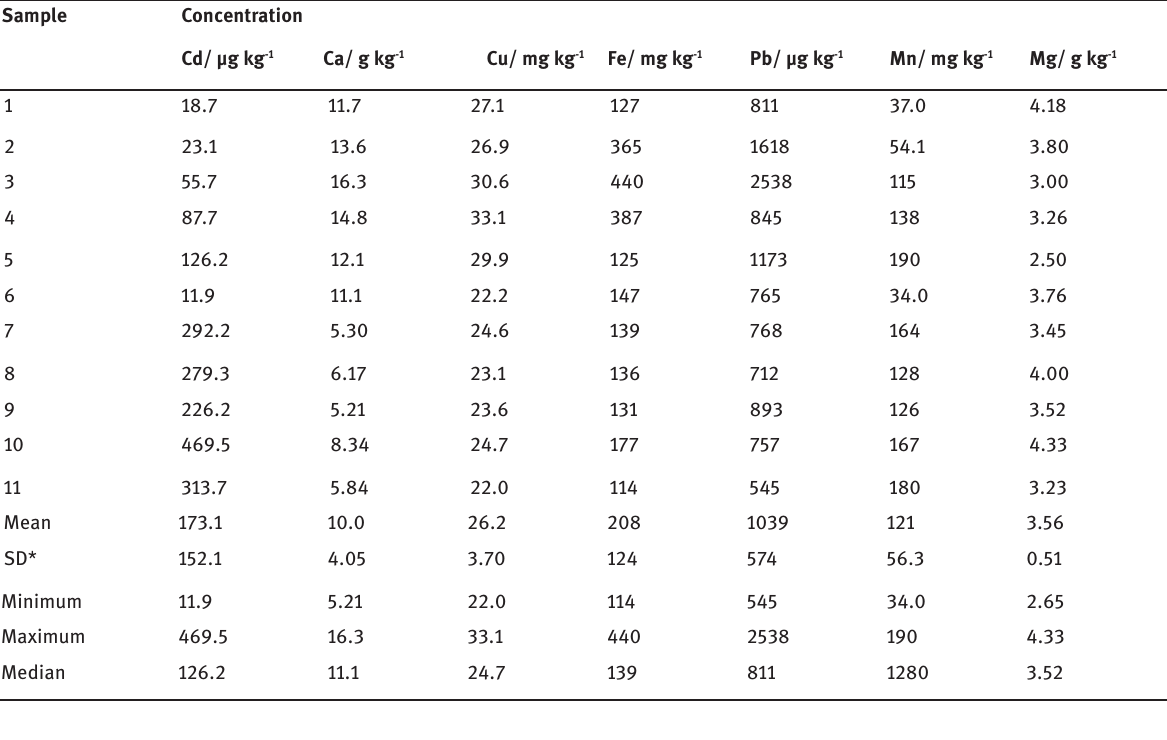
Table 5: Factor loadings for metal content in tea samples of sage, linden and chamomile ( n = 7).